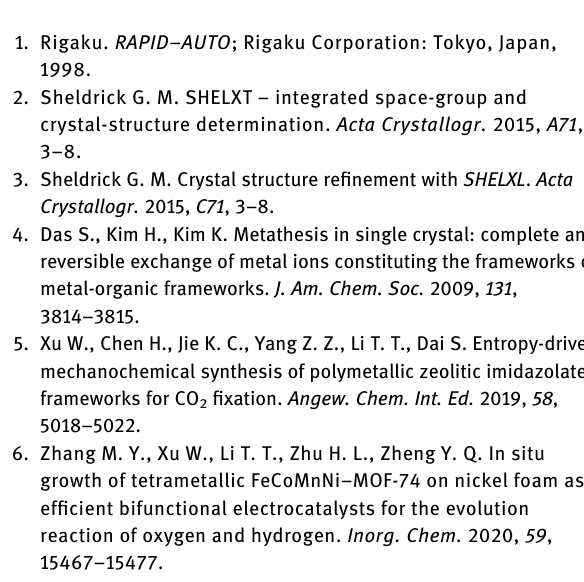
(#1 = − x , − y + 2, − z + 1), which are in good agreement with those reported for similar complexes [17]. The Cu / Cu distance is 2.578(1) Å, which is observed within the normal range for dinuclear paddle-wheel units in the structures of Cu II carboxylate complexes [18, 19]. The dinuclear Cu II units are further connected to form one-dimensional chains by hydrogen bonds [d(O5 / O1 #2 = 2.900(4) Å, O5 –